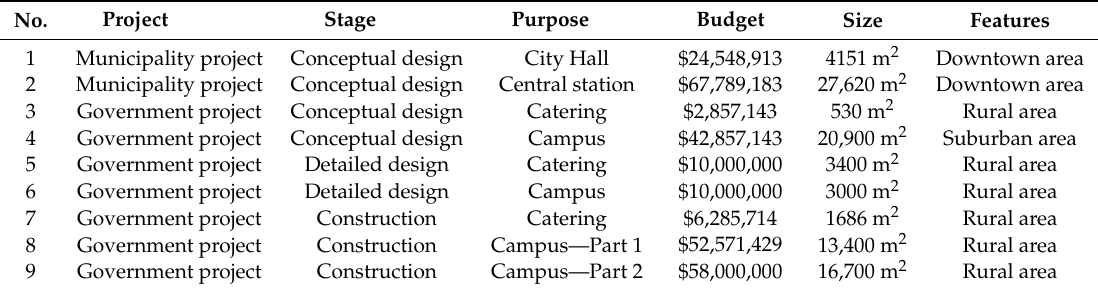
Table 4. Characteristics of the